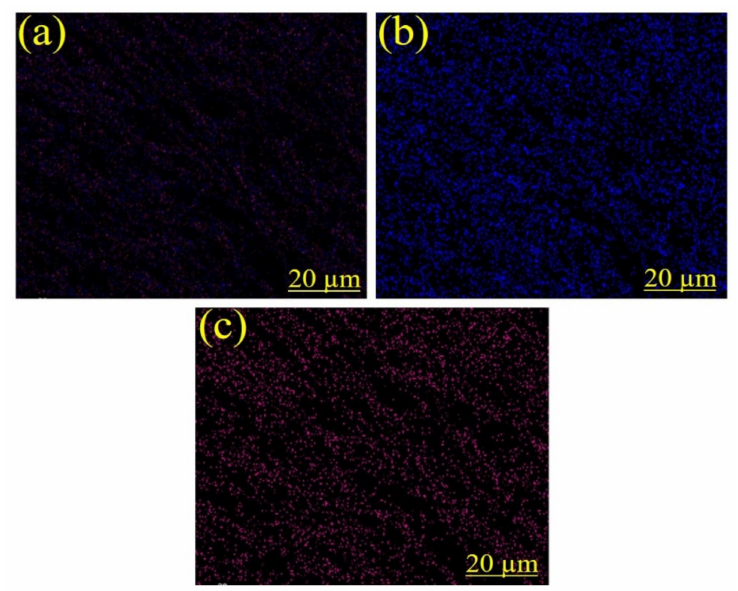
Figure 6. SEM-EDS elemental mapping images of PLA; ( a ) C & O mapping, ( b ) C mapping, and ( c ) O mapping.